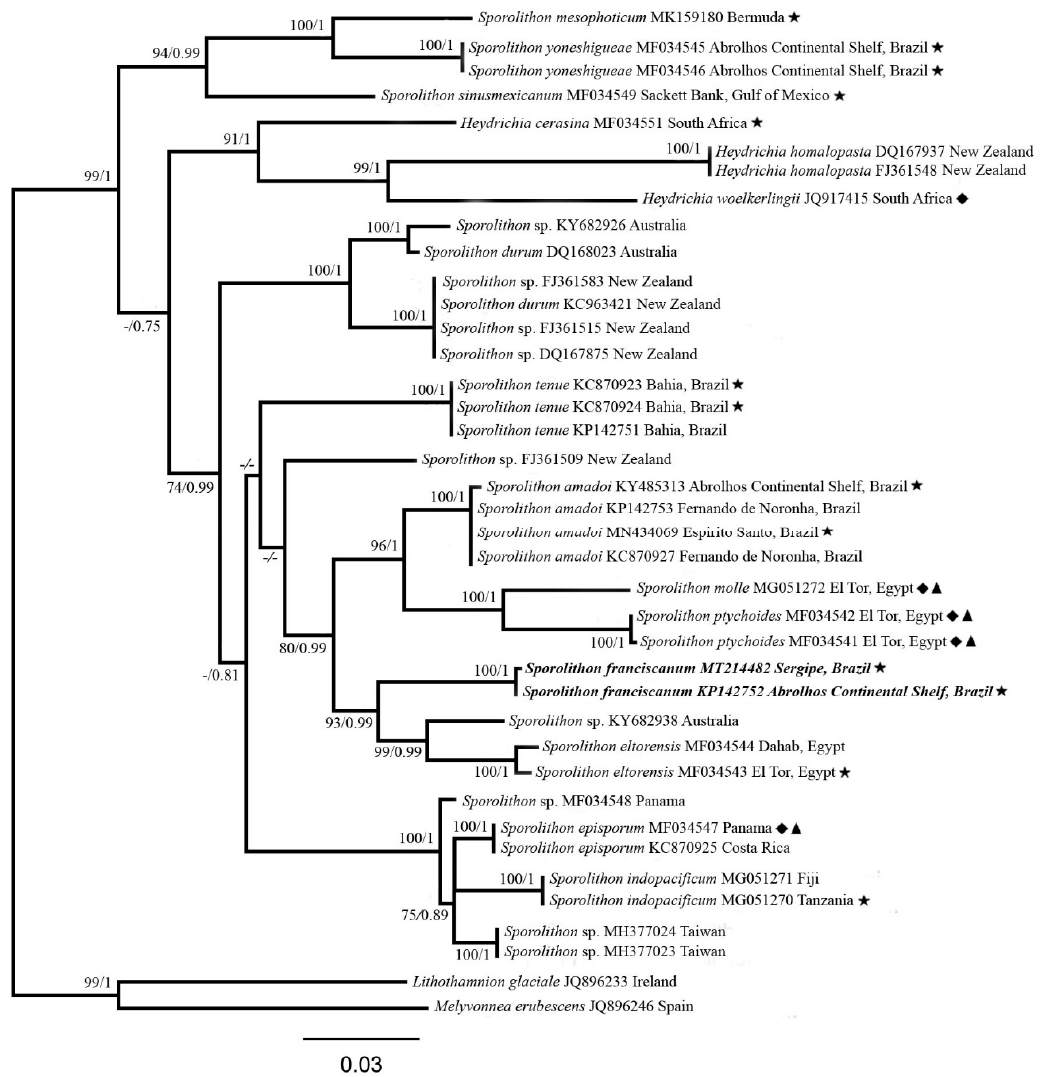
Figure 1. Phylogenetic tree inferred from RAxML (Randomized Axelerated Maximum Likelihood) and BI (Bayesian inference) analyses of the psb A dataset. Bootstrap support (1000 replicates) and Bayesian posterior probabilities (PP) are indicated at nodes. Bootstrap values lower than 70% and PP lower than 0.70 are not shown. Melyvonnea erubescens and Lithothamnion glaciale were used as outgroups. Sporolithon franciscanum sp. nov. is marked in boldface type. Stars represent holotype, isotype, neotype, or paratype specimens; diamonds represent topotype specimens (specimens from the type locality); triangles represent species whose identification was confirmed by comparison of DNA sequences with type material.